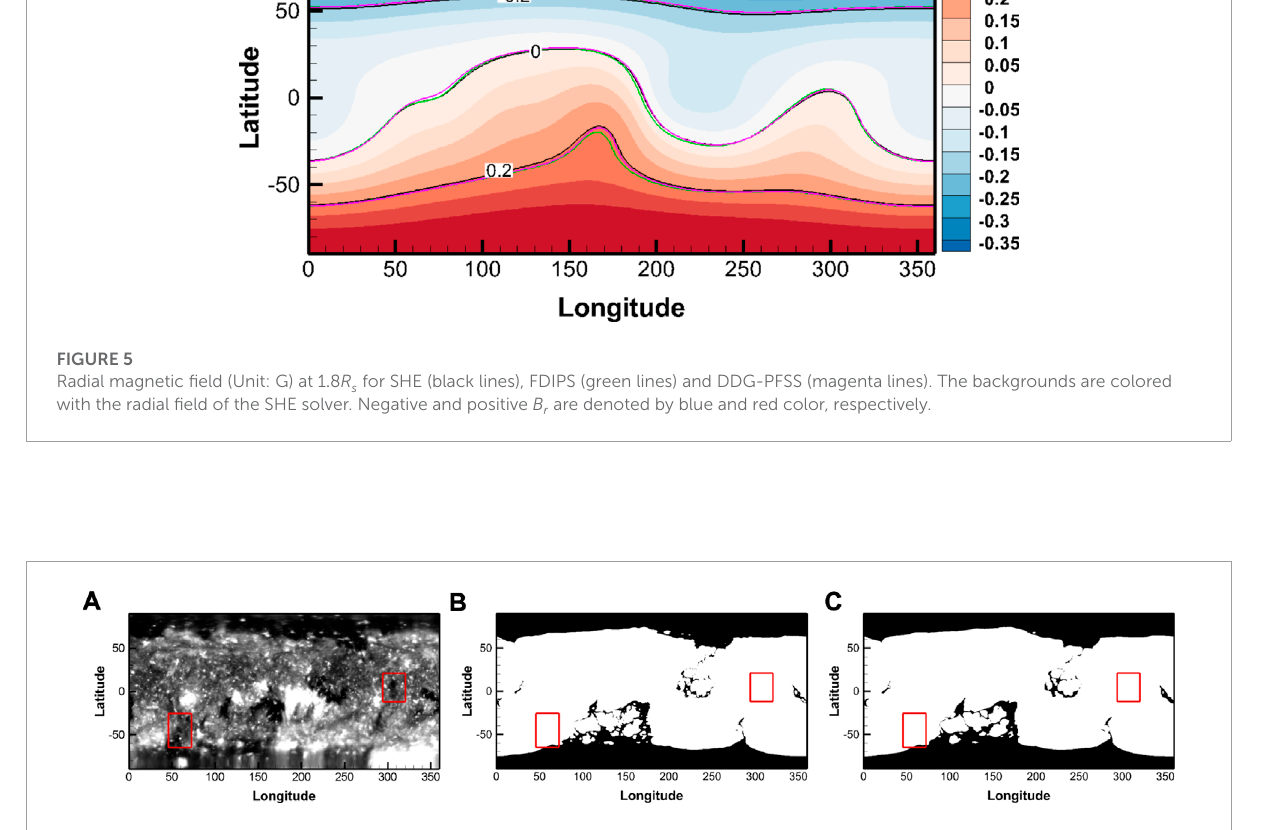
FIGURE 6 Synoptic maps of coronal holes: (A) observed by EUVI/SECCHI on board STEREO A; (B) obtained by the SHE solver; (C) obtained by the DDG-PFSS